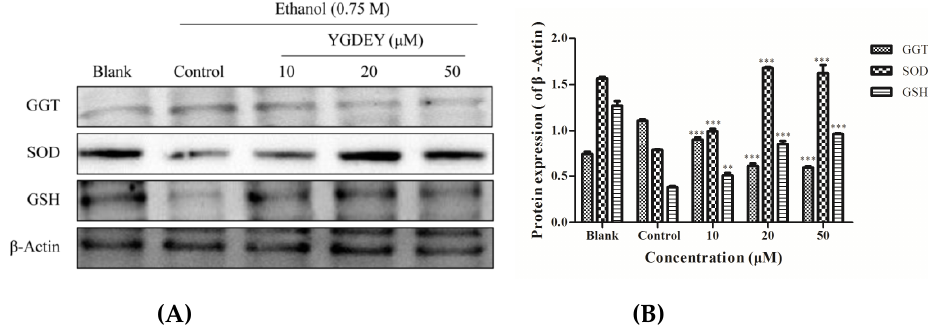
Figure 3. ( A ) Western blot analysis to examine the effect of YGDEY on SOD, GSH, and GGT in ethanol-induced HepG2 cells. YGDEY (10, 20, and 50 μM) was added to cells for 24 h before treatment with 0.75 M ethanol for 2 h. β-Actin was used as an internal control. ( B ) Protein expression (relative to β-Actin) was evaluated. Data are shown as means ± SD ( n = 3). ** compared with the control group, p < 0.01. *** compared with the control group, p < 0.001.